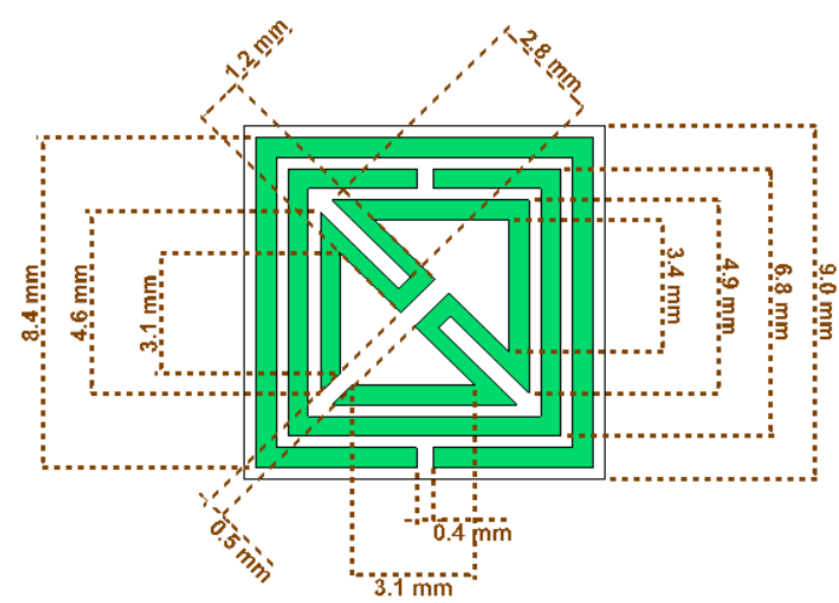
Figure 1. Metamaterial unit cell with specifications of dimensions.